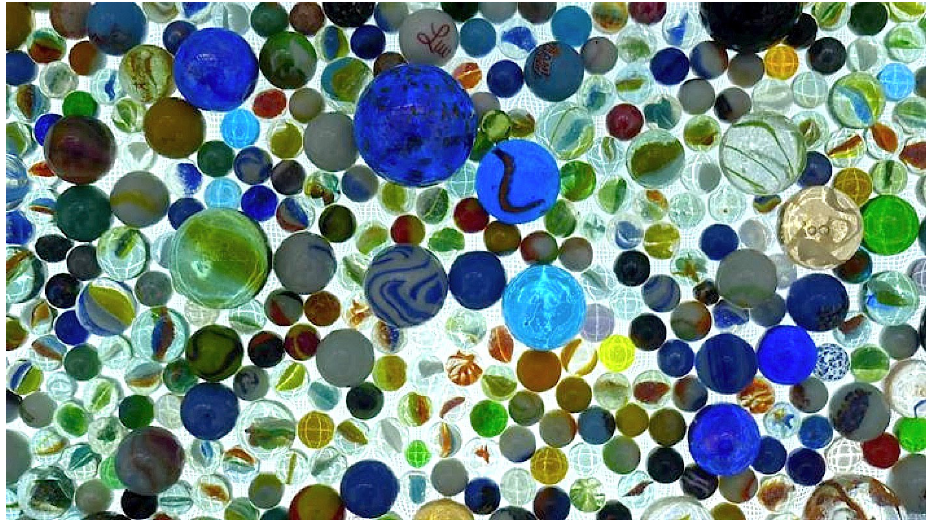
Figure 2: Rob Scholte: Light your first